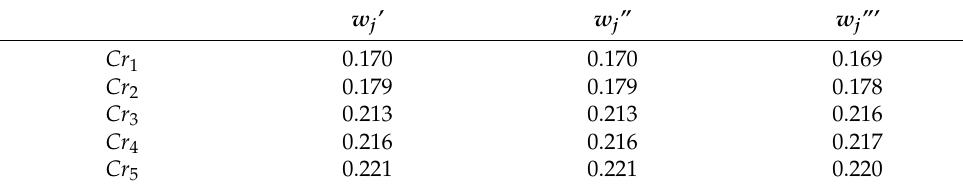
Table 17. The criteria weight obtained using three